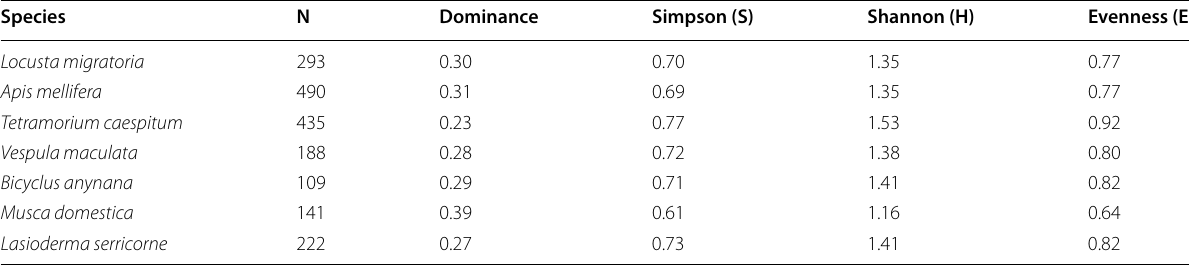
Table 5 Diversity indices for identified insects around a telecommunication mast